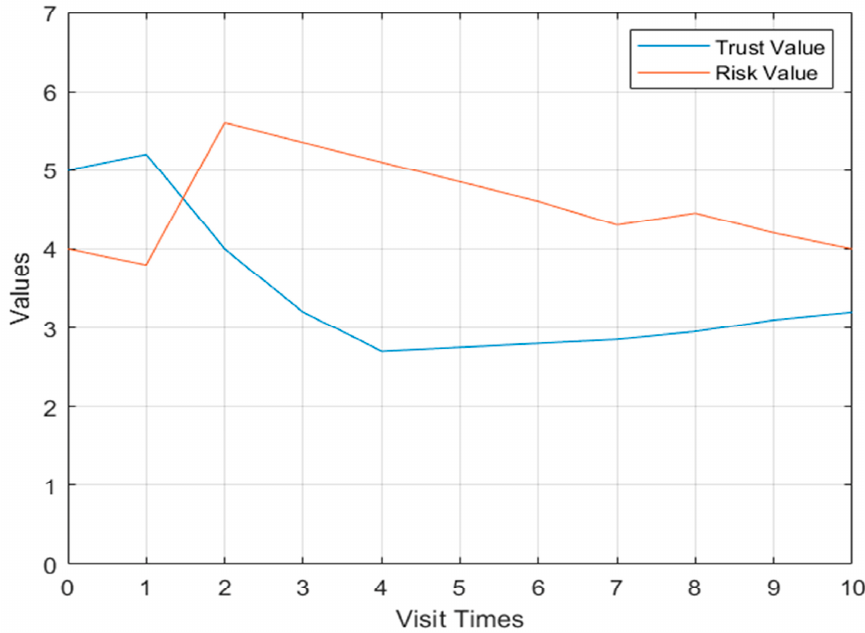
Figure 4. Flow chart of dynamic access control.